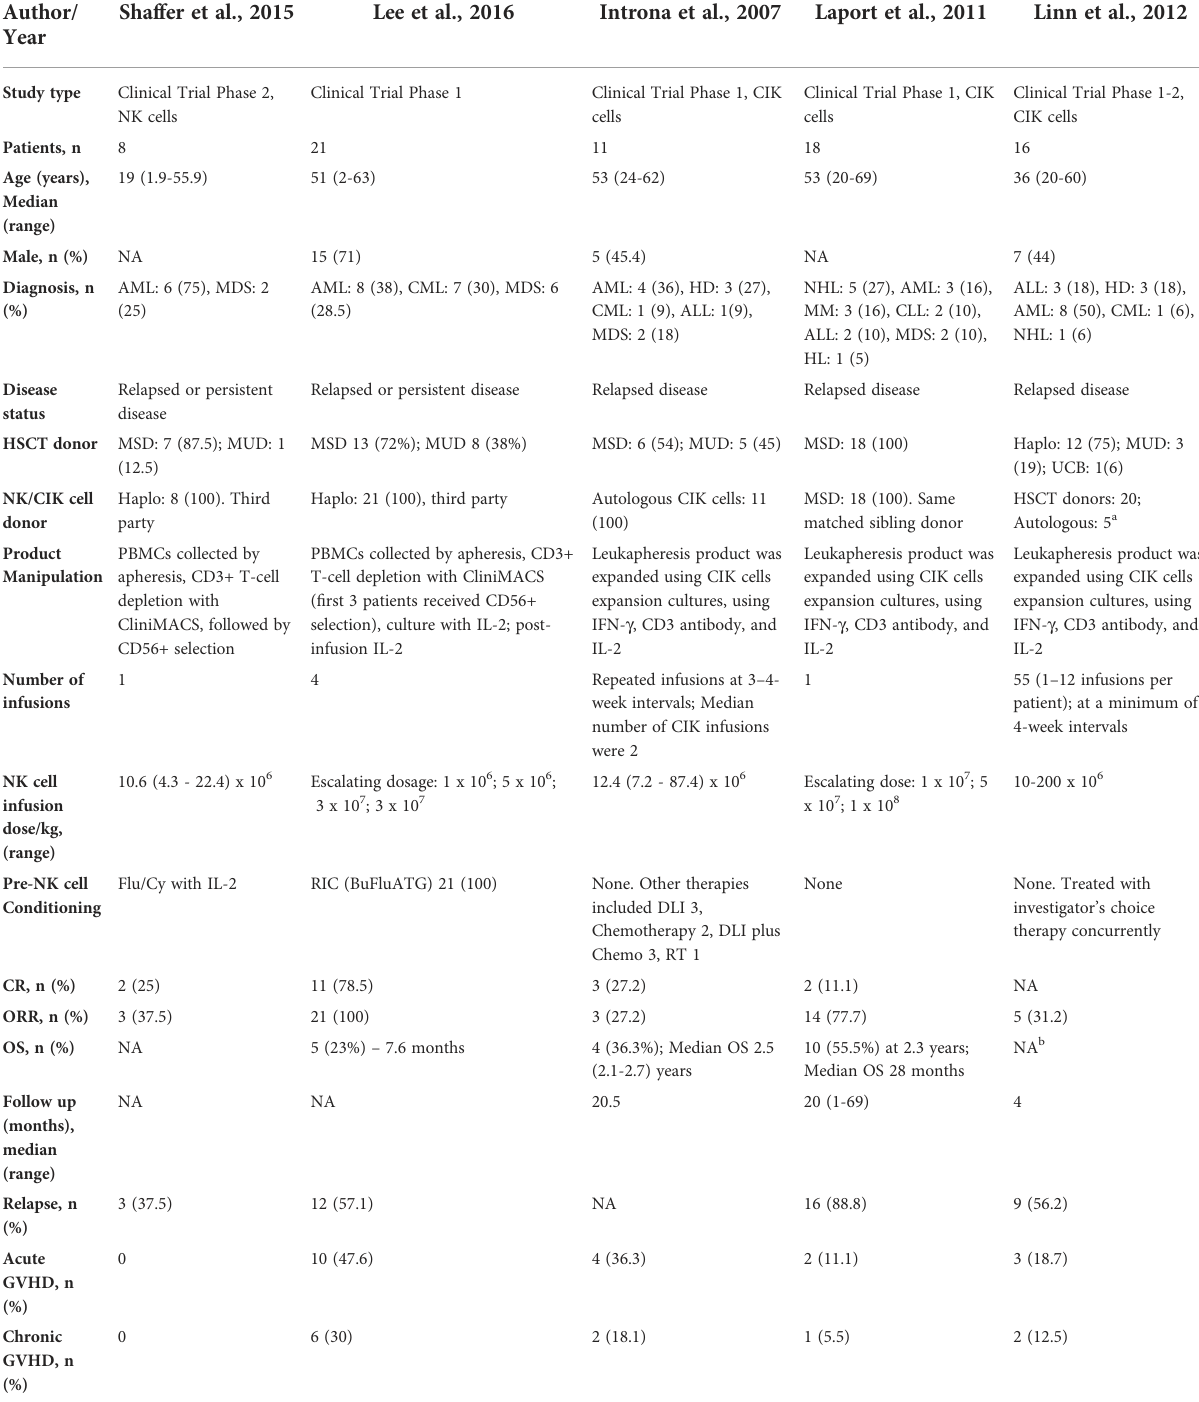
TABLE 3 Impact of therapeutic use of NK and CIK cell infusions on outcomes after allogeneic